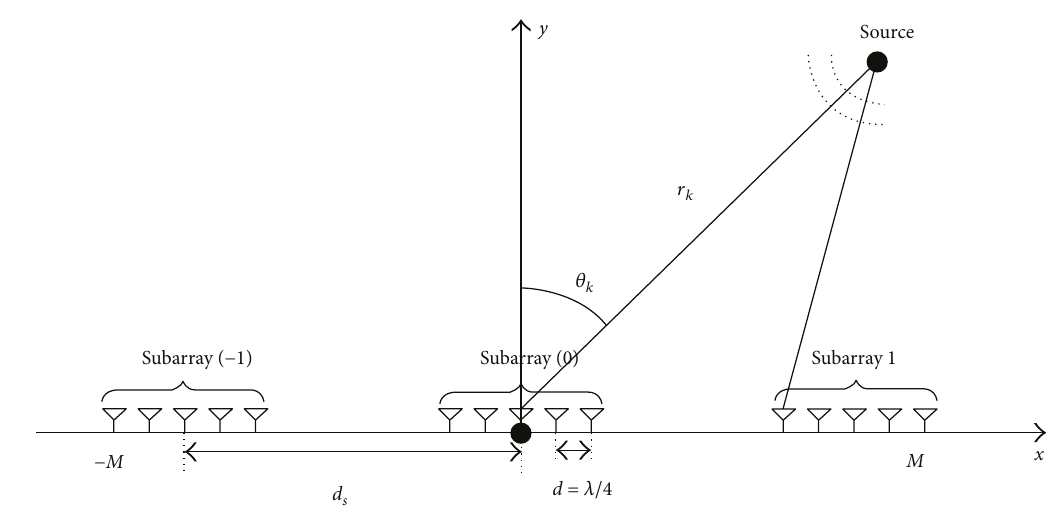
Figure 1: Sparse linear array